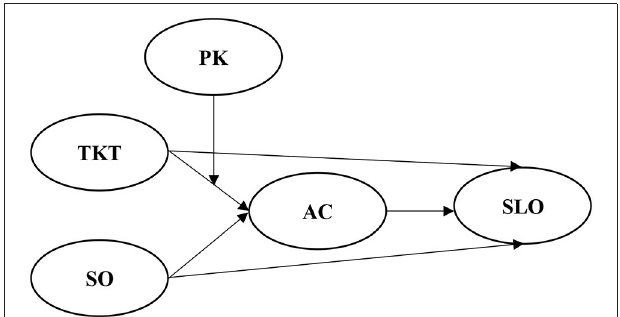
FIGURE 1 | Research